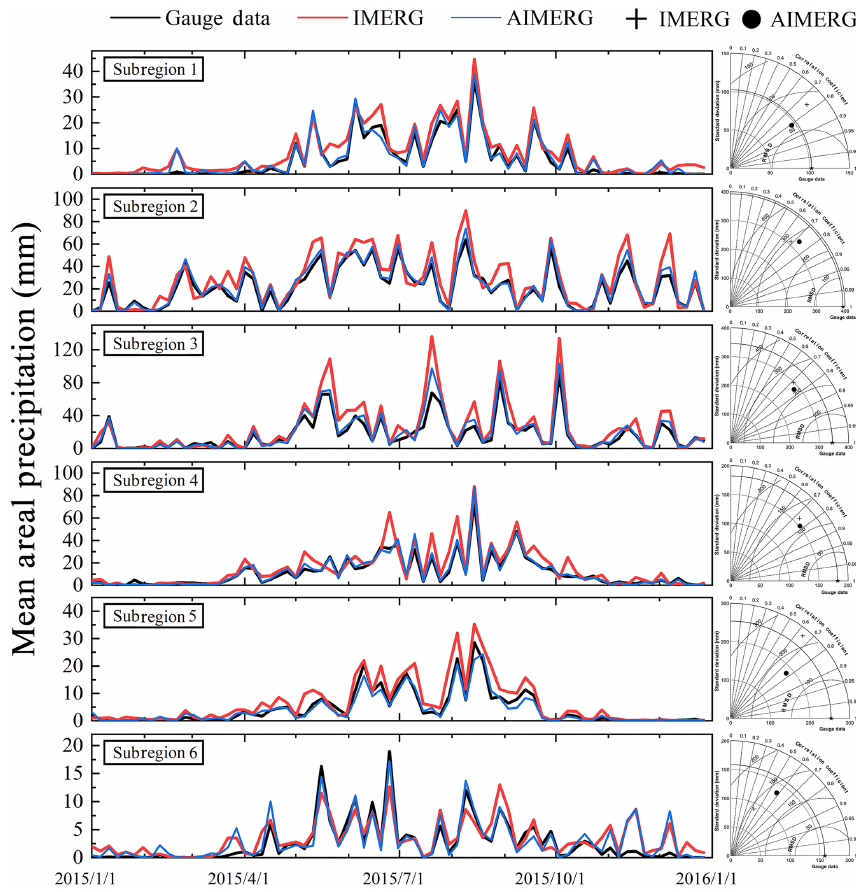
Figure 7. The temporal patterns and the volumes of IMERG, ground observations, and AIMERG in six subregions at a daily scale, and the Taylor diagrams of performances on IMERG and AIMERG against ground observations in terms of the centred root-mean-square difference, correlation coefficient, and standard deviation in the six subregions at an hourly scale in